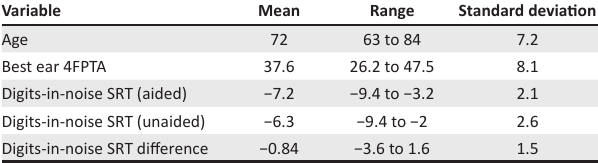
TABLE 2: Descriptive statistics for aided and unaided hearing aid digits-in-noise speech reception thresholds ( n = 9).